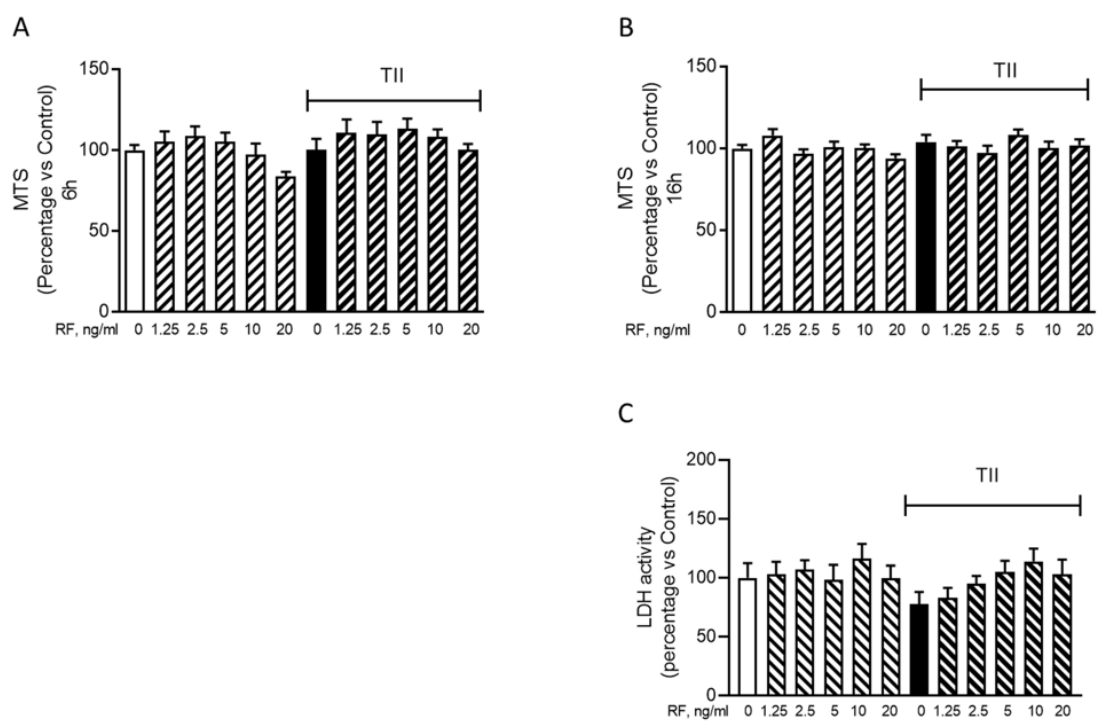
Figure 3: Effects of remifentanil on cell viability and cytotoxicity. ( A-B ) Cell viability was detected by MTS reduction assay at two different time points, 6 h ( A ) and 16 h ( B ). C20 cells were treated with remifentanil (RF) alone at different concentrations and in combination with 50 pg/ml TII. Results are shown as fold changes versus Control, set as 100 %. Results are pooled analysis of three independent experiments. Data are means ± SEM (n=14) and were analyzed by one-way ANOVA followed by the Bonferroni's post hoc test. ( C ) The cytotoxic effects of the treatments were assessed by measuring the release of LDH in the incubation medium after 16 h incubation, taken as an index of cell toxicity. None of the treatments was toxic for C20 microglial cells. Results are shown as fold changes versus Control, whose optical density was set as 100 %. Results are pooled analysis of three independent experiments. Data are means ± SEM (n=12-14) and were analyzed by one-way ANOVA followed by the Bonferroni's post hoc